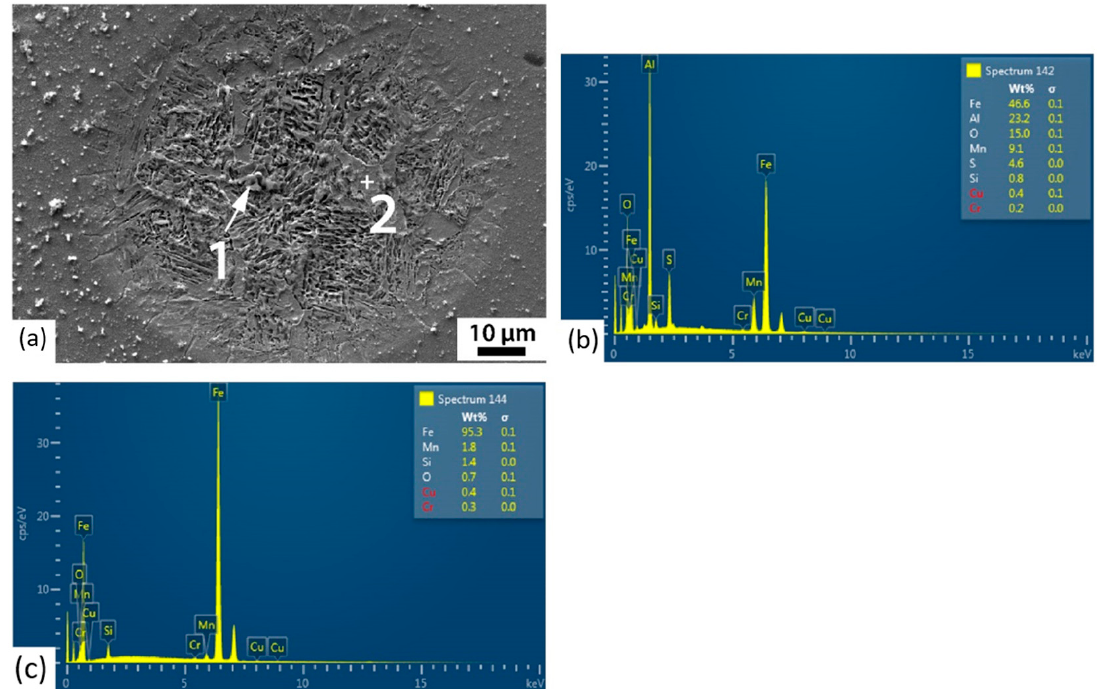
Figure 12. Mn-Si-HT steel after 20 min immersion (demineralized water), ( a ) corrosion pit with marked locations for EDS analysis; ( b ) EDS spectrum—point 1; ( c ) EDS spectrum—point 2. Table 6. Mn-Si-HT steel, results from EDS analysis of the corrosion spot in wt.%.